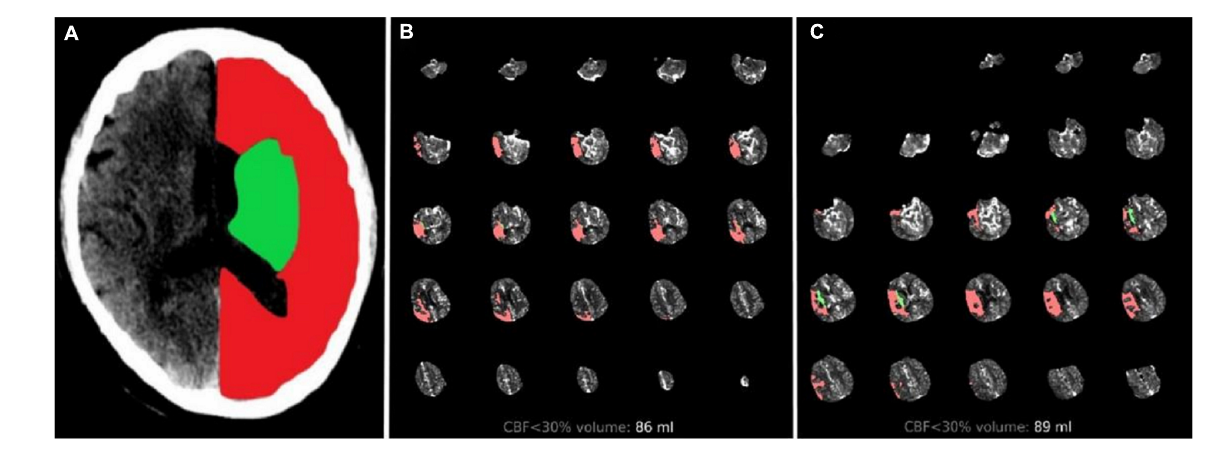
FIGURE2 Two cases treated with endovascular treatment taken as example. Illustrative cases: (A) Green region represents SIV and red region represents CIV. (B) Patient with total core infarct volume = 86 ml, SIV = 1.3 ml, and CIV = 84.7 ml. Them RS score was 1 at 90 days after the follow-up. (C) Patient with total core infarct volume = 89 ml, SIV = 9.4 ml, and CIV = 79.6 ml. Them RS score was 4 at 90 days after the follow-up. SIV, subcortical ischemic volume; CIV, cortical ischemic volume; mRS, modified Rankin